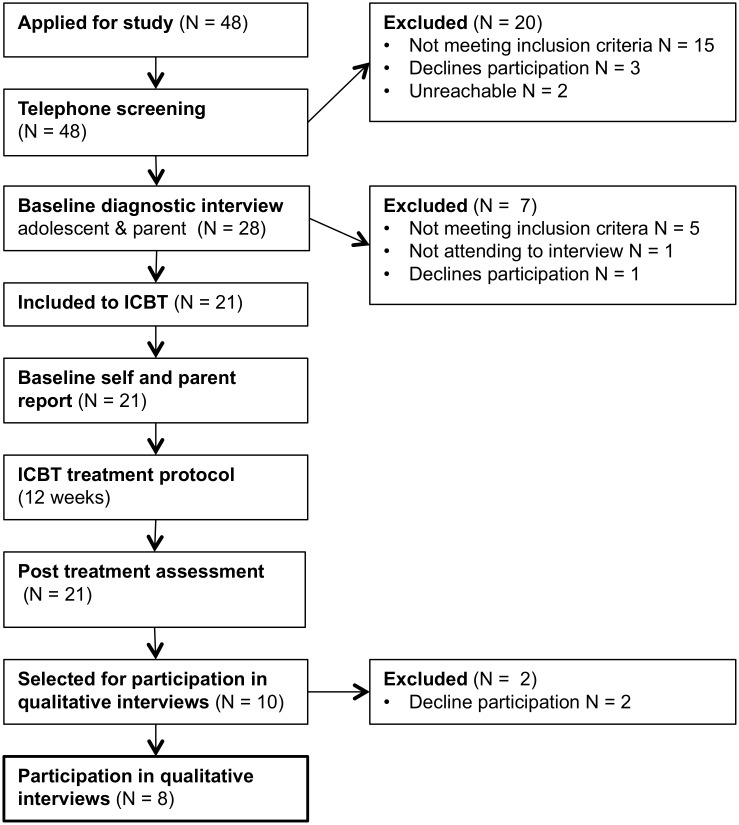
Study flow chart.